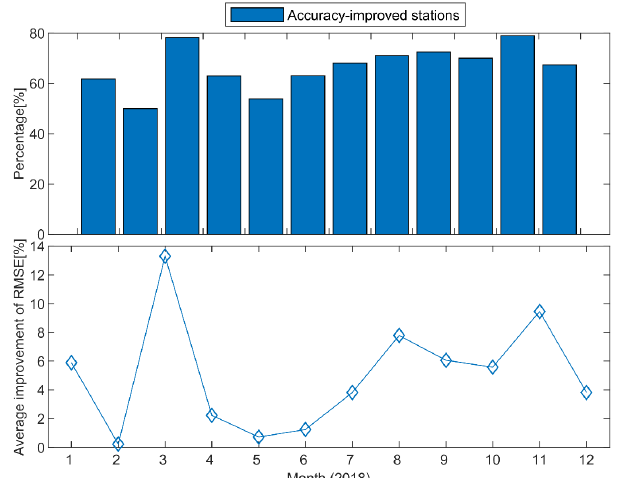
Figure 10. Statistical improvements of Scheme 3 at all stations. The up sub-figure depicts the proportion of accuracy-improved stations. The average improvement of RMSE at all stations is shown in the down subfigure.